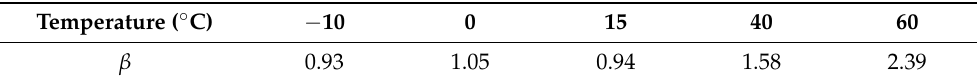
Table 5. The fitting values of α and β under five groups of temperatures. Temperature ( ◦ C) − 10 0 15 40 60 β 0.93 1.05 0.94 1.58